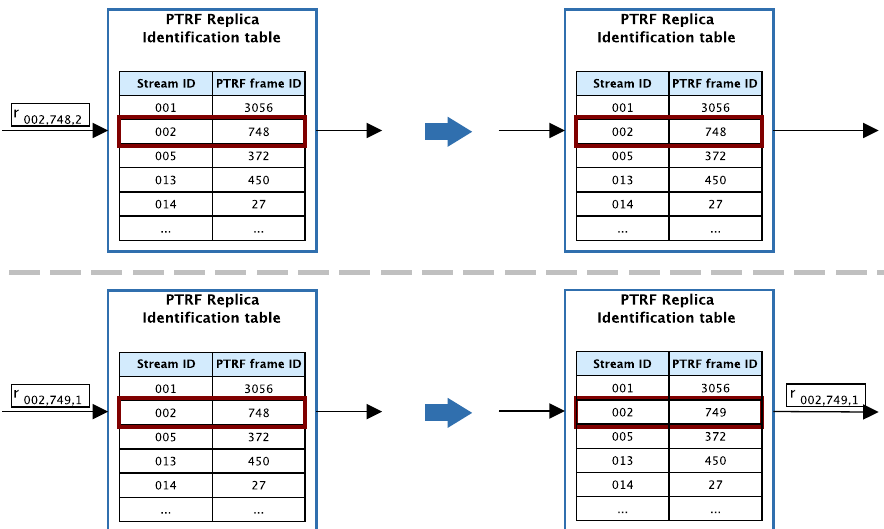
Figure 11. This figure shows the operation of the PTRF Replica Identification table. Specifically, on the top of the Figure, we see how the table processes a replica of a message edition that has previously been received. On the bottom, we see how the table processes a replica of a message edition that is received for the first